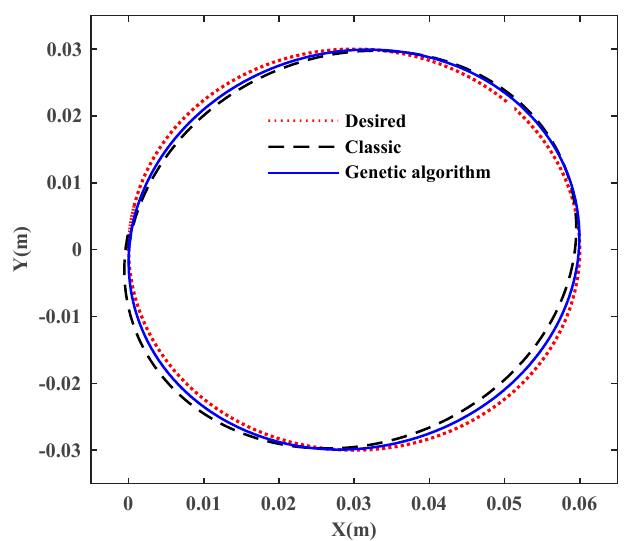
Figure 9. Trajectories of the end-effector using the classic PID and the PID optimized by a genetic algorithm.